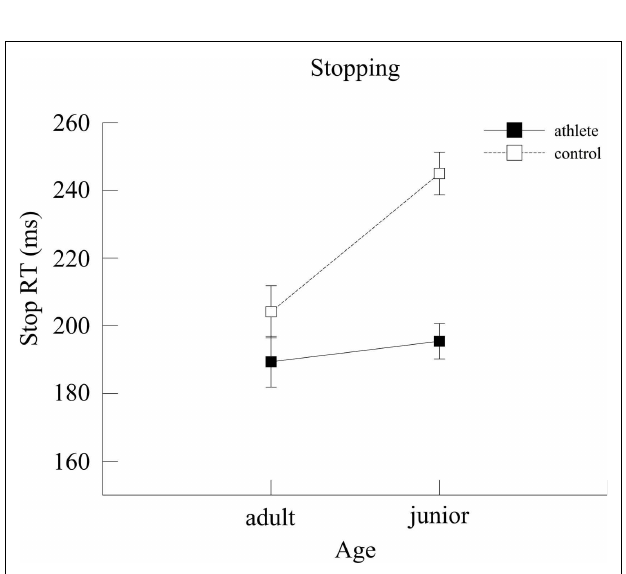
= 0.03] were observed, as illus- [ F (1,139) = 3.68, p = 0.06, η 2 p trated in Figure 4 . The analysis indicated a higher probabil- ity of stopping in the athlete group. Post hoc analyses showed that there was no significant age difference between adult and junior athletes ( p = 0.78) but junior controls (0.54 ± 0.01 ms) had a higher probability of stopping ( p = 0.02) than adult controls (0.53 ± 0.01 ms). In addition, the analyses revealed that junior athletes (0.56 ± 0.01 ms) had a significantly higher probability of stopping ( p < 0.001) than junior controls (0.54 ± 0.01 ms)